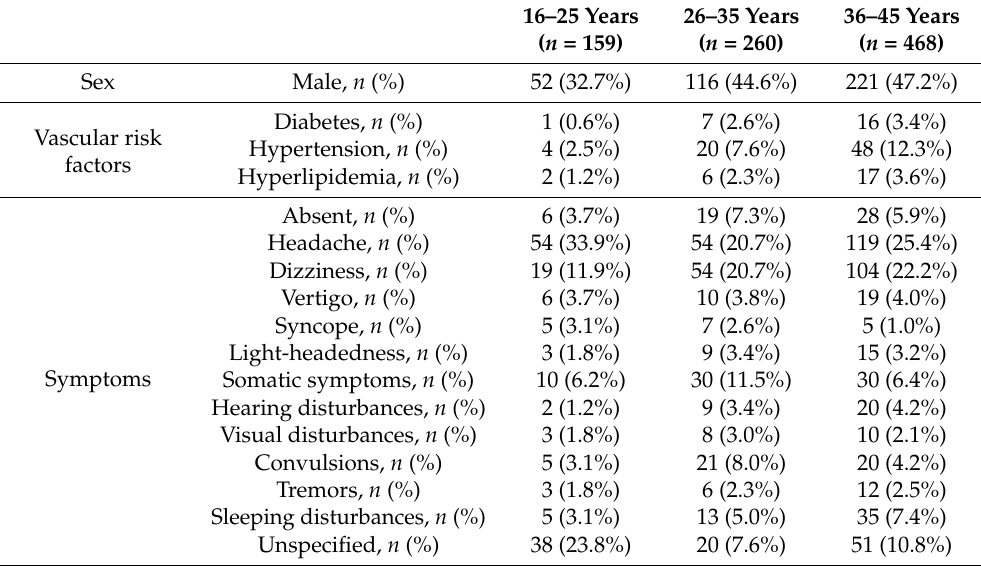
Table 1. Basic patient information and clinical data in subjects grouped by